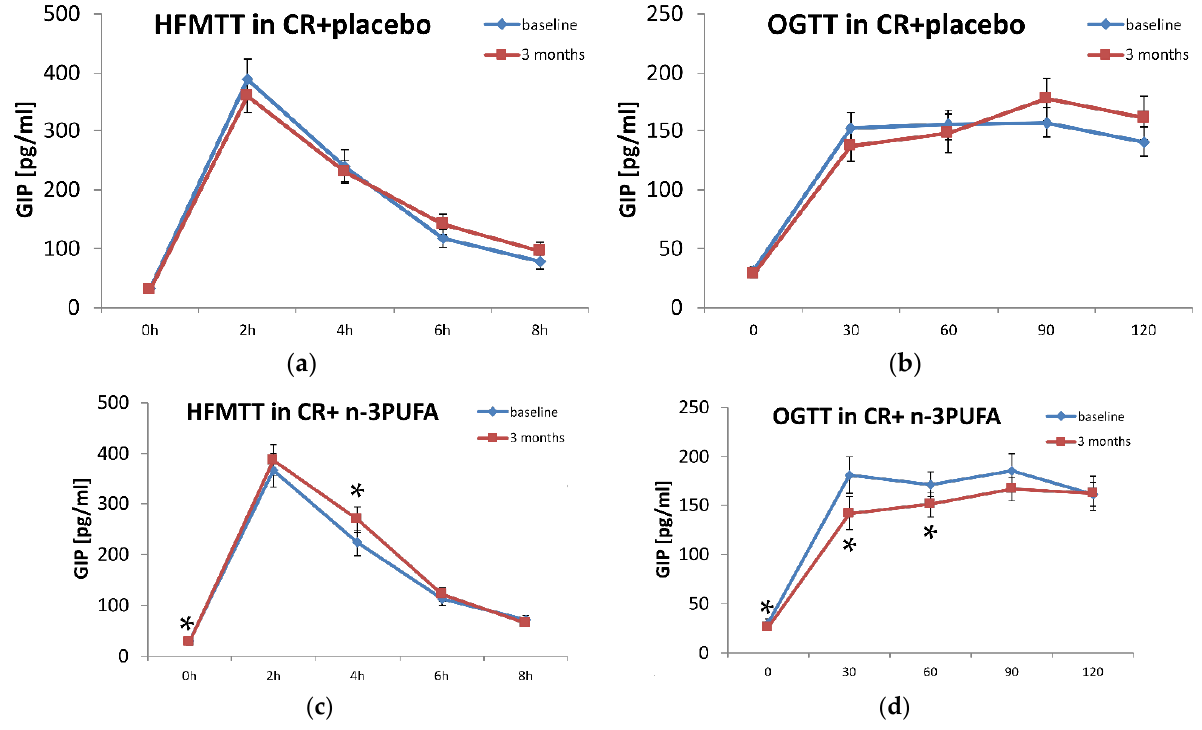
Figure 2. Plasma GIP levels during High Fat mixed Meal Tolerance Test (HFMTT) ( a , c ) and Oral Glucose Tolerance Test (OGTT) ( b , d ) in plasma of placebo ( a , b ) or n-3 PUFA ( c , d ) supplemented obese participants. Mean and SEM (bars) presented for baseline (blue line) and after 3-month supplementation (red line). * p < 0.05 paired t -test. CR — caloric restriction .